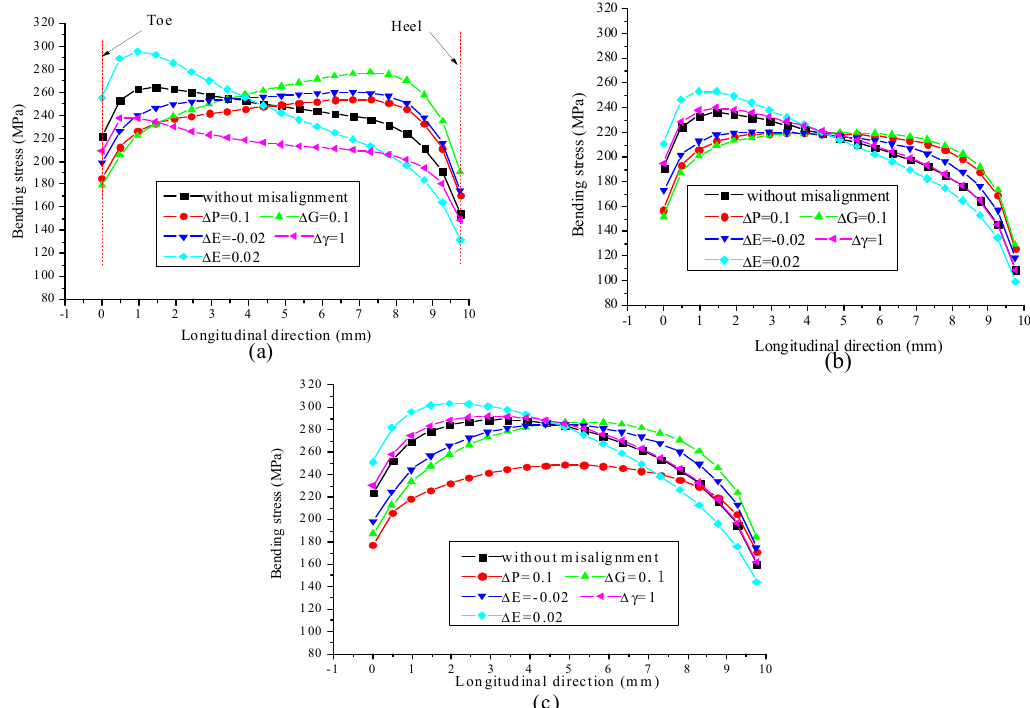
Figure 20. Bending stress distribution for the driving pinion in different installment conditions—( a ) no modification, ( b ) tooth end relief (Case4) and ( c ) symmetric crowned modification (Case 1).